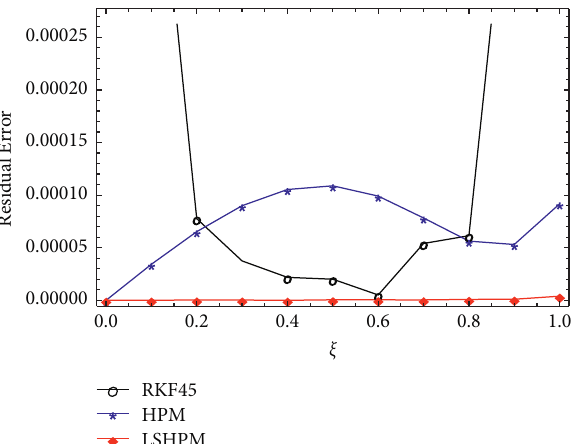
Figure 1: Comparison of errors for RKF45, HPM, and LSHPM when R � 0 . 5 ,M